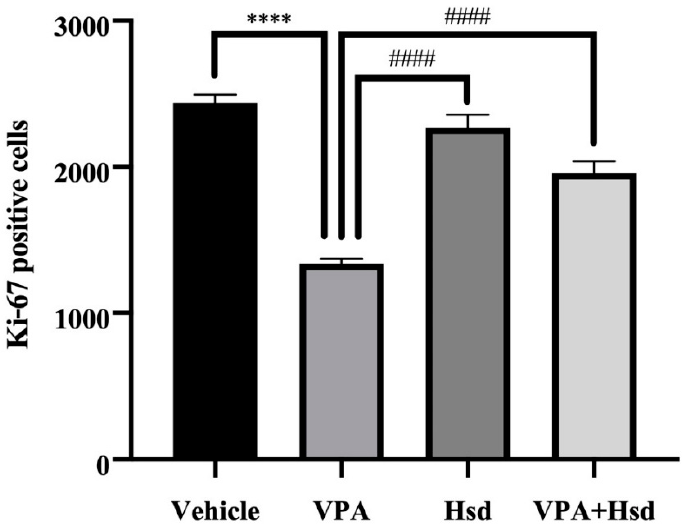
Figure 6. The number of Ki-67-positive cells in the VPA group was significantly lower than in the vehicle (**** p < 0.0001), Hsd and VPA+Hsd groups (#### p < 0.0001).